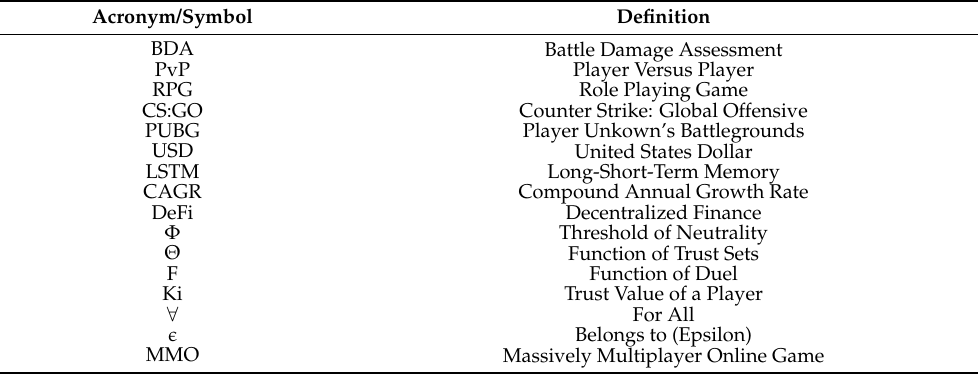
Table A1. List of acronyms and symbols used in the